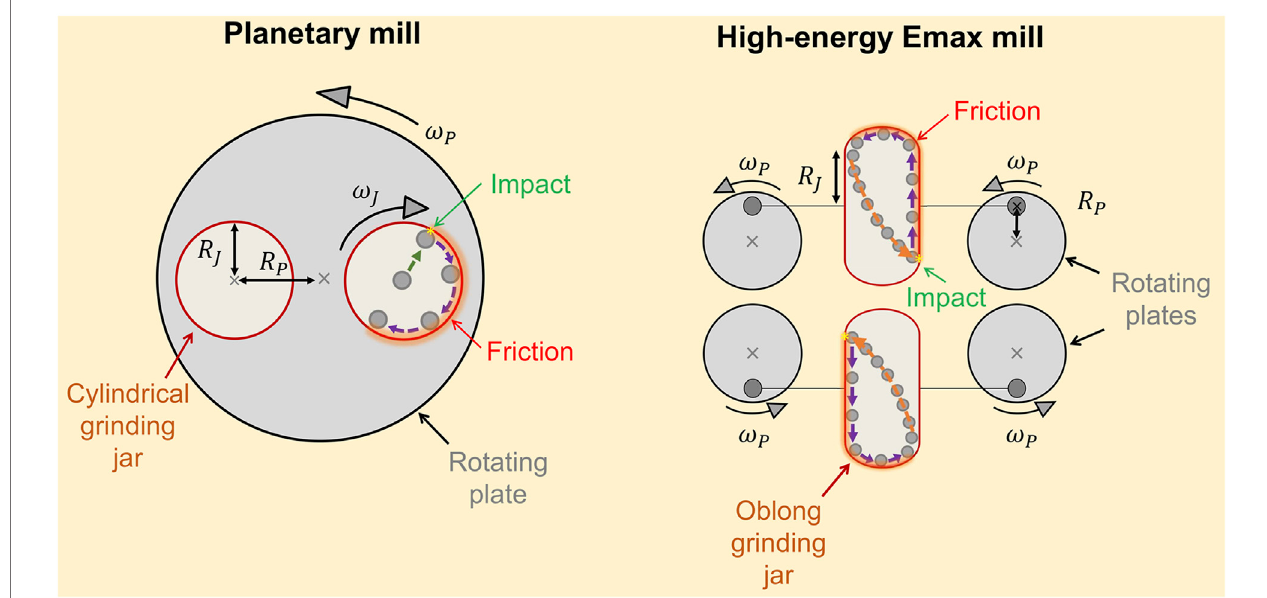
FIGURE1| Simpli fi edrepresentationofthekeyfeaturesofthemechanicaldesignoftheplanetarymill ( left ) andthehigh-energyEmaxmill ( right ) .Inthisschematic representation, the trajectory of a ball for each grinding jar geometry is presented. The asterisk “ * ” in yellow color represents ball-wall impact points, and the blue arrows indicate the idealized moviment of the ball on the wall creating a ball-wall friction zone. For clarity, no representation of the grinding medium bulk is presented. However, ball-ball friction becomes substantial when loading the jar with a large number of balls of small diameter. Detailed information about the internal dimensions of the jars is presented in Supplementary Figure S1 ( Supplementary Material ).